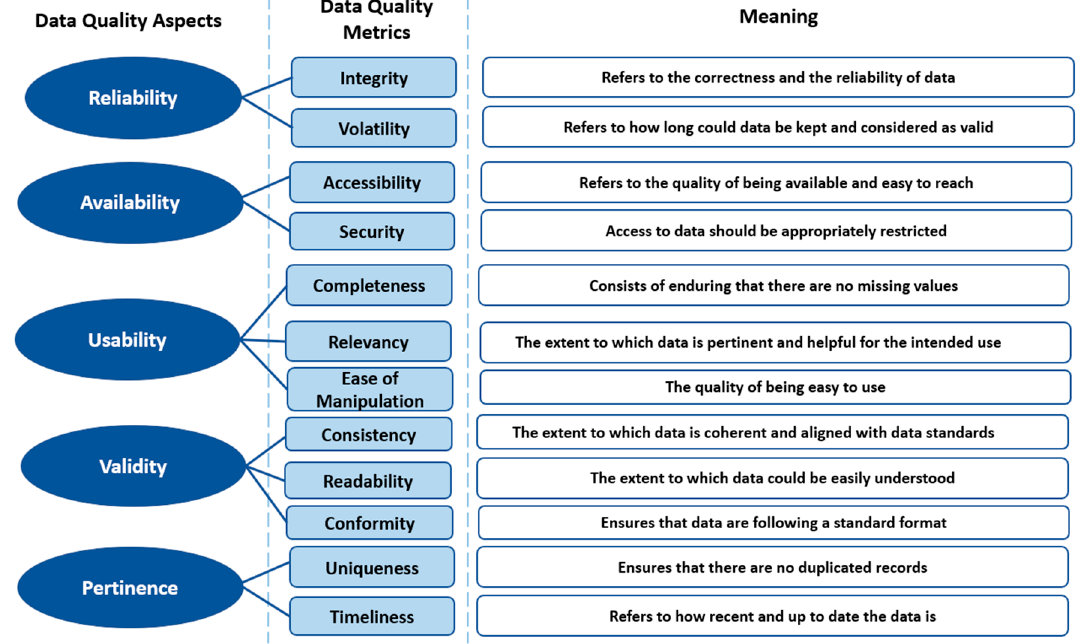
Figure 5. Data Quality Aspects and Metrics.